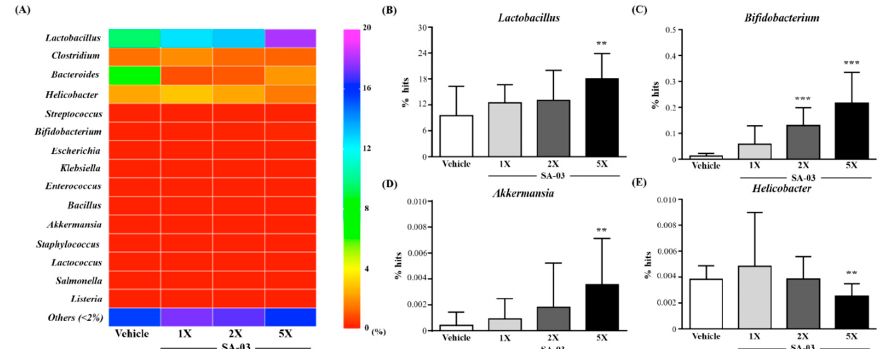
Figure 7. Effect of 4 weeks of SA-03 supplementation on ( A ) Genus heatmap of gut microbiota, ( B ) Lactobacillus % hit , ( C ) Bifidobacterium % hit, ( D ) Akkermania % hit and ( E ) Helicobacter % hit. Data are expressed as mean ± SD for n = 9 mice per group. Values with different superscript letters are significantly different at *, p < 0.05; **, p < 0.05; ***, p < 0.05 by t -test. Microorganisms 2020 , 8 , x FOR PEER REVIEW In Species (Figure 8A) , the number of Lactobacillu in SA-03 supplementation of mice were total increase, among them, Lactobacillus salivarius , Lactobacillus reuteri , Lactobacillus vaginalis , and Lactobacillus antri were more abundant than the vehicle group. In comparison, the percentage changes of Lactobacillus species in SA-03-1X, SA-03-2X and SA-03-5X were 4.23%, 9.07%, and 16.55%, respectively.